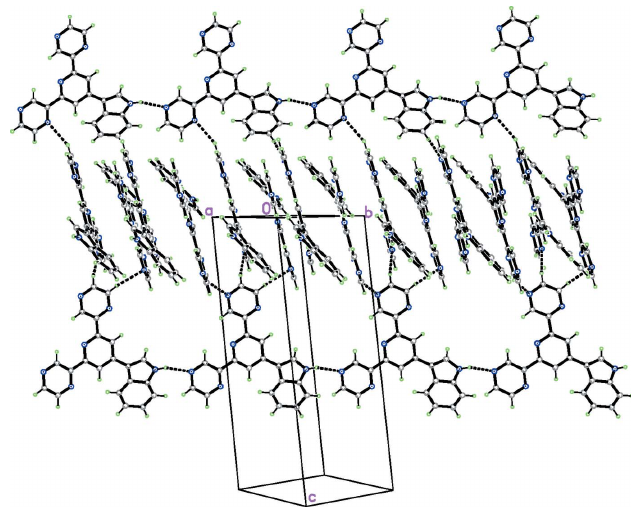
Figure 2 The hydrogen-bonding interactions (dashed lines) in the title